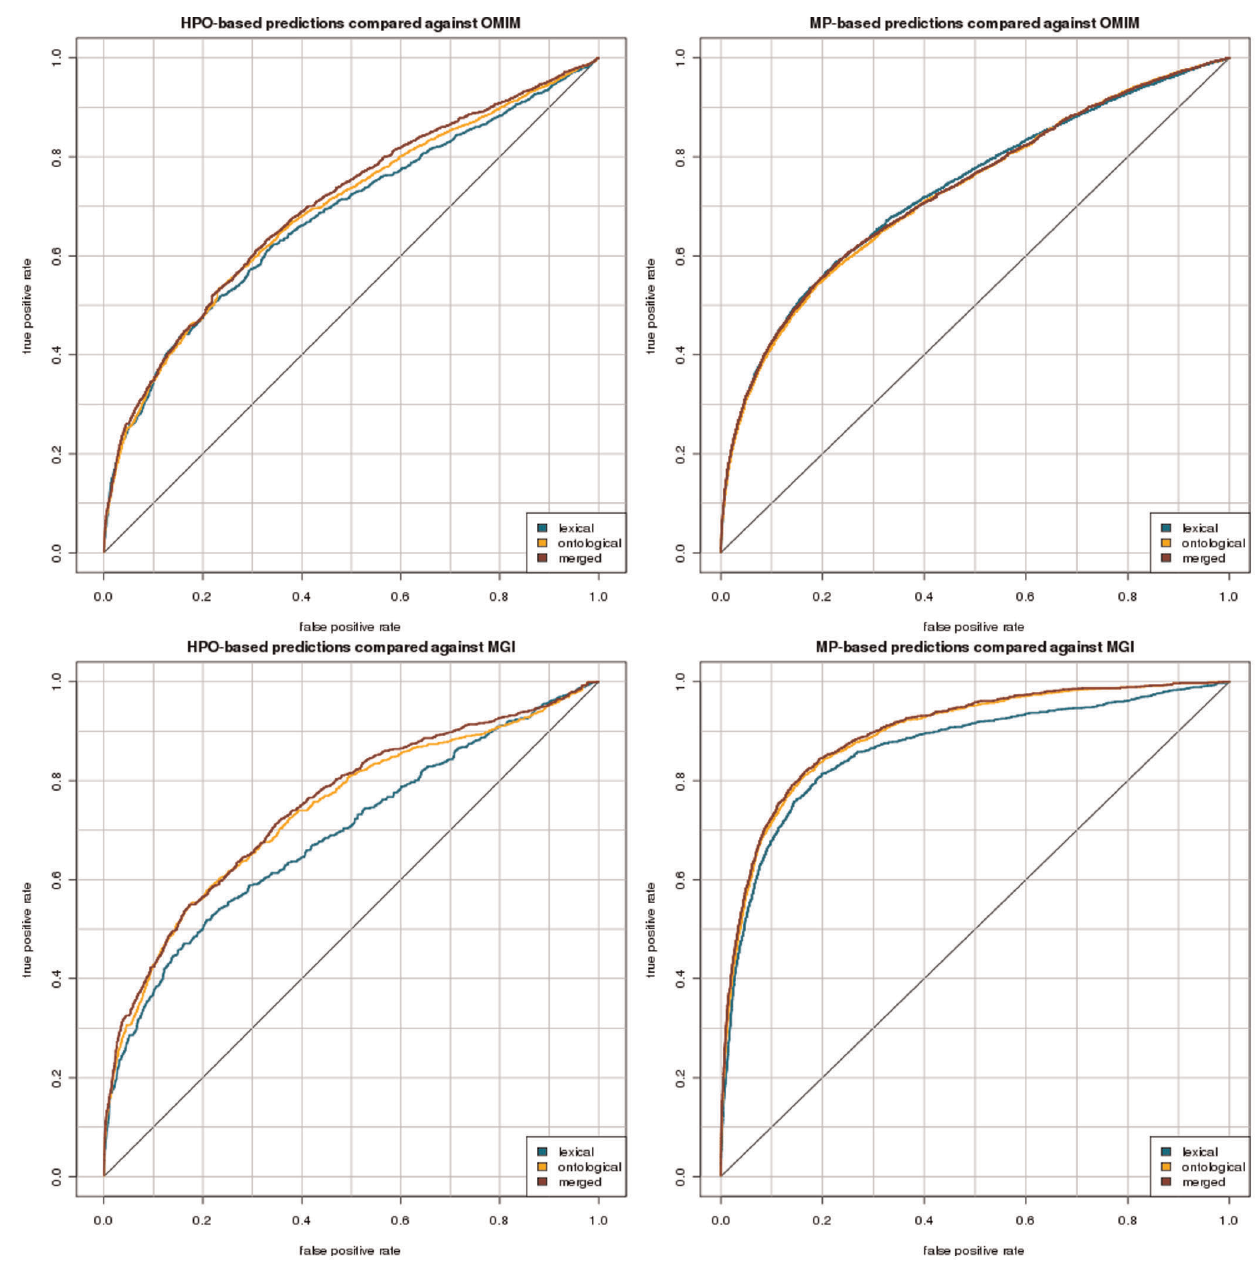
Figure 4. ROC curves resulting from our evaluation. The left panel includes all the results for ‘‘translating’’ mouse models from an MP representation to an HPO representation and performing the gene prediction in HPO. The right panel includes all the results for a ‘‘translation’’ of human diseases into an MP-based representation. Each plot shows the evaluation results using each of the three mappings: using lexical matching, using reasoning over ontologies, and the merged mappings. The two panels on the top are the results of the evaluation against OMIM and the two panels at the bottom are the results of the evaluation against MGI.